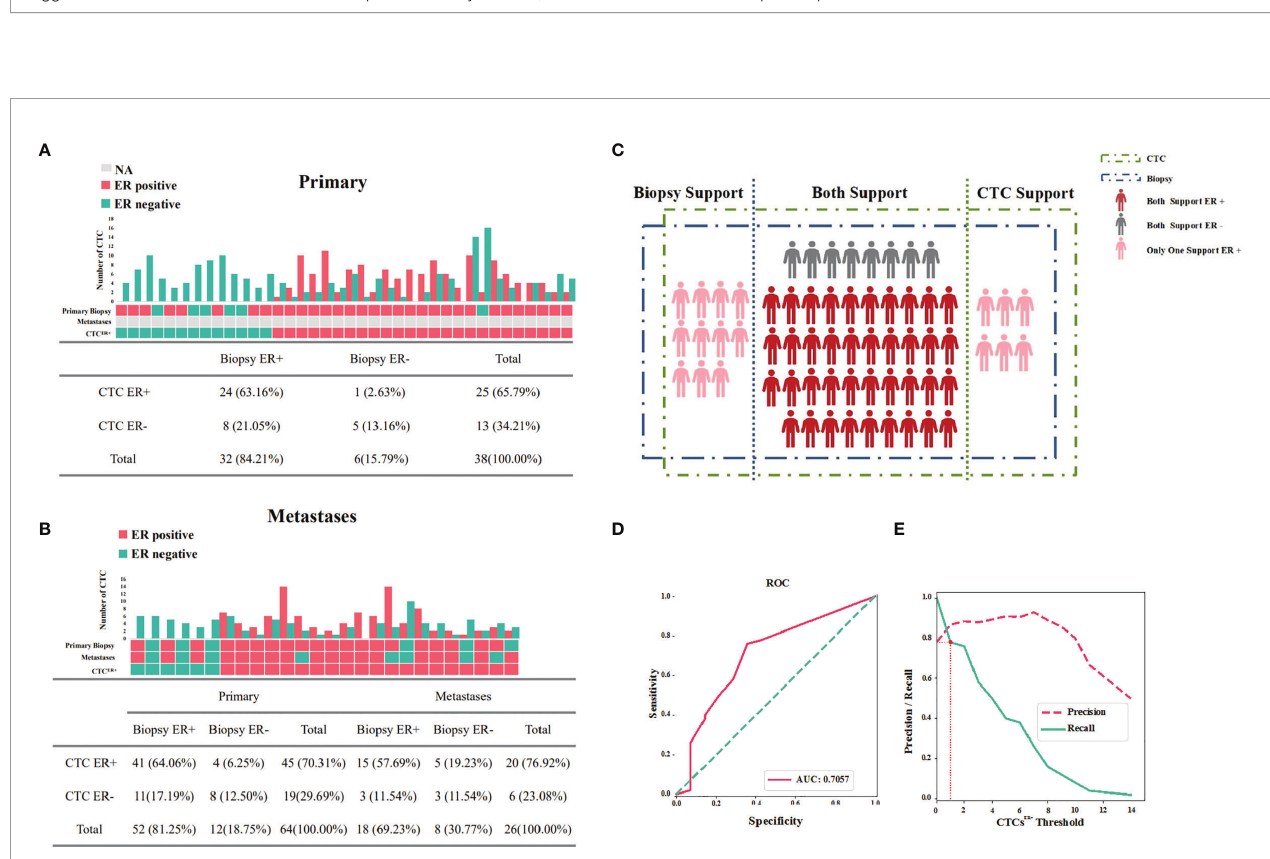
FIGURE 2 | Comparisons of CTC enumeration between BC patients and female controls. (A, B) The difference of CTC numbers within 2 ml of blood between BC patients and female controls was extremely signi fi cant (P<0.0001) (A) with AUC being 95.81% (B) . (C) The optimal threshold based on precision-recall curve suggested that ≤ 2 CTCs within 2 ml of blood predict healthy females, whereas more than 2 CTCs predict patients.